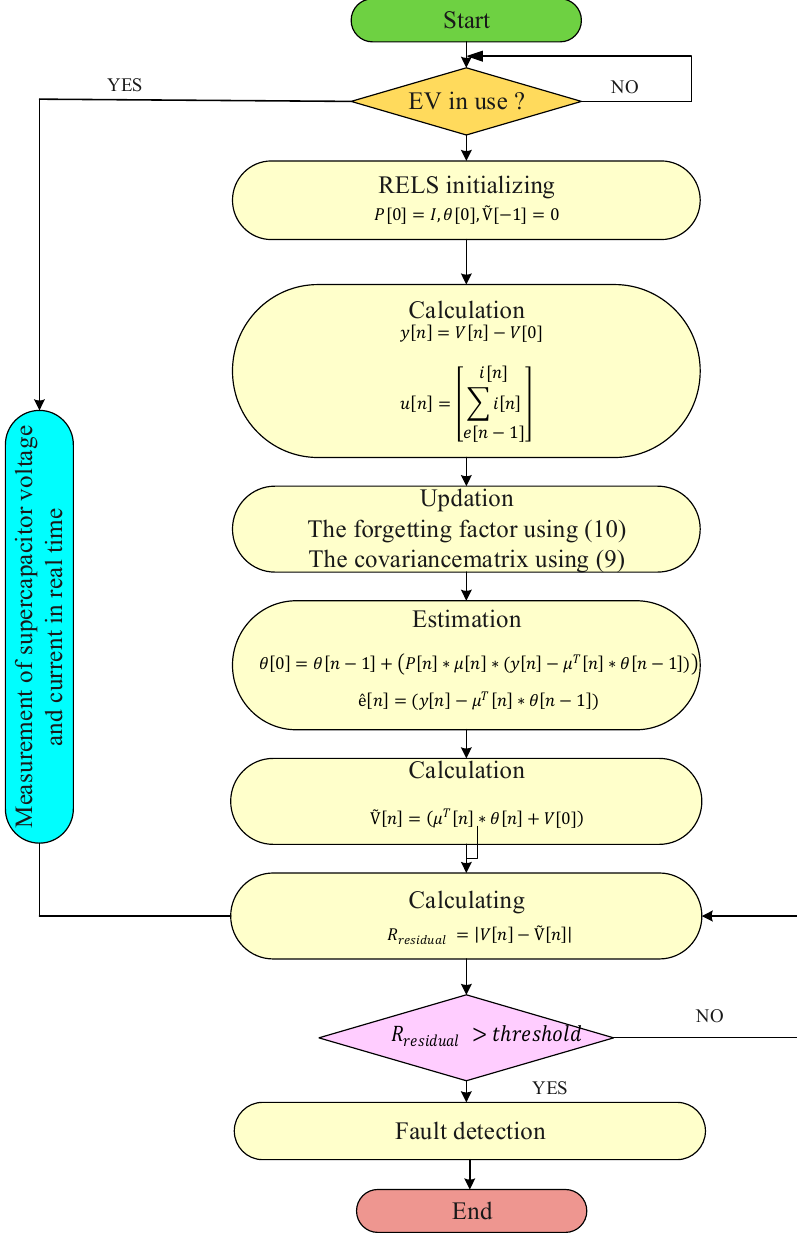
Figure 8. RELS model-based for SOH estimation of supercapacitor.